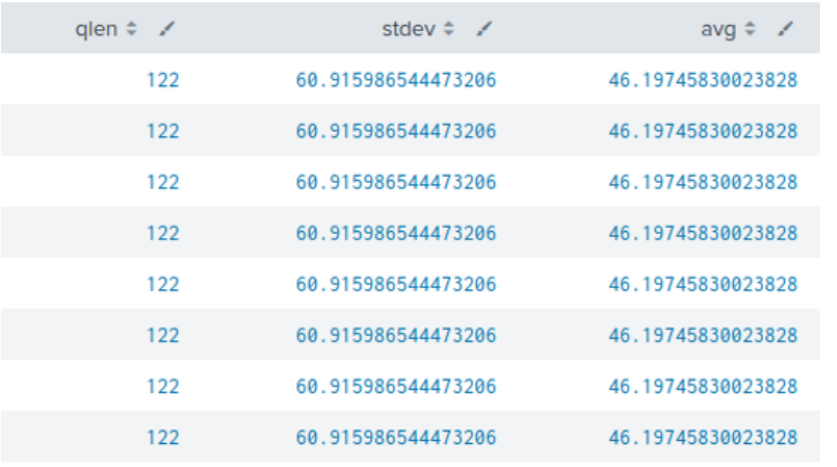
Figure 10. First column shows the DNS query length for the ns.slehee.uk subdomain. The second column shows the standard deviation between the elements of the first and second columns. The third column lists the query length averaged over the last seven